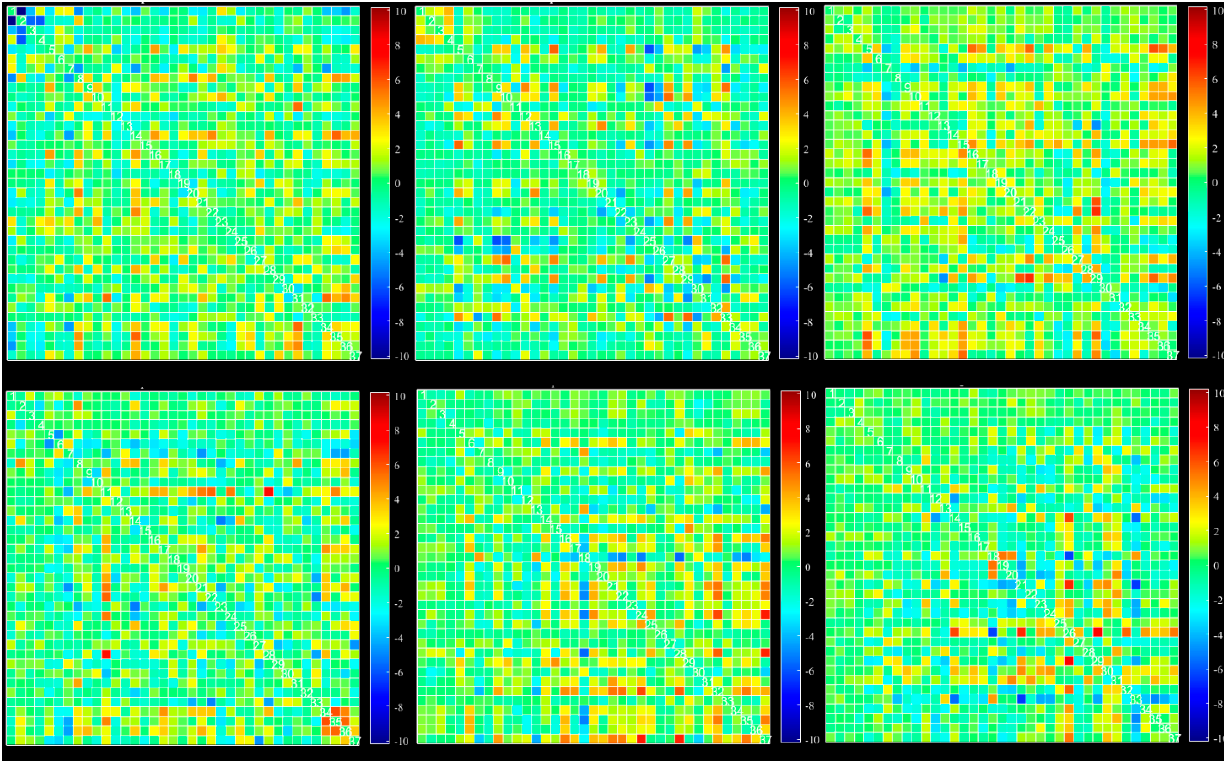
Figure 6. Dynamic functional connectivity of all 37 extracted ICs: six different states, selected based on ICA from all windows .